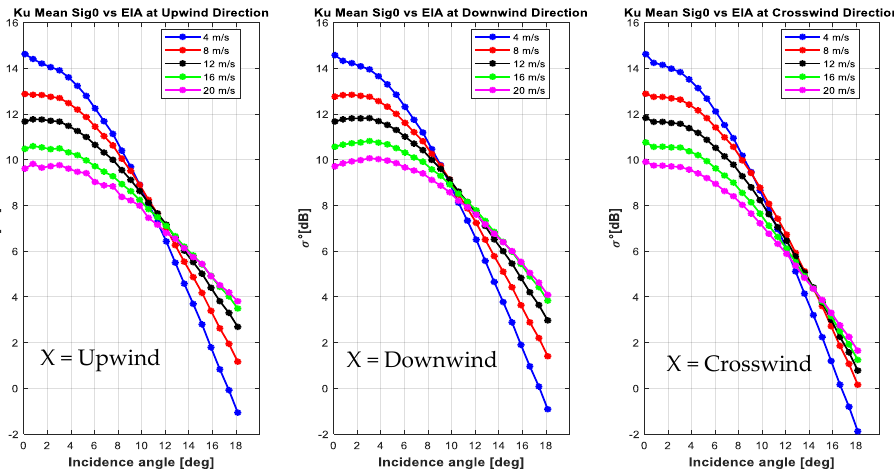
Figure 9. Mean value of binned σ 0 (in dB) at KuPR ( left ) and KaPR ( right ) as a function of earth incidence angle θ, for different wind speeds.